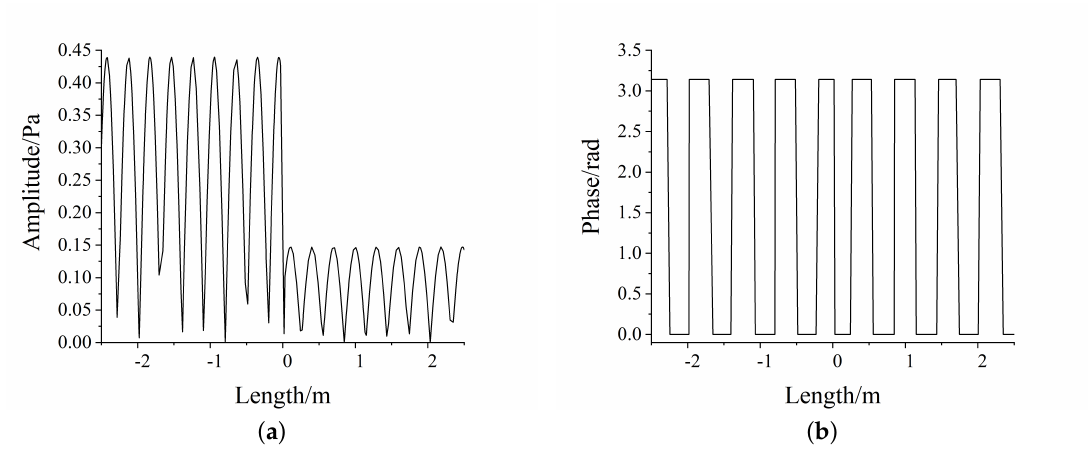
Figure 7. ( a ) The information of sound pressure amplitude in sound tube inner with steel sample at 2500 Hz. ( b ) The information of sound pressure phase in sound tube inner downstream with steel sample at 2500 Hz.